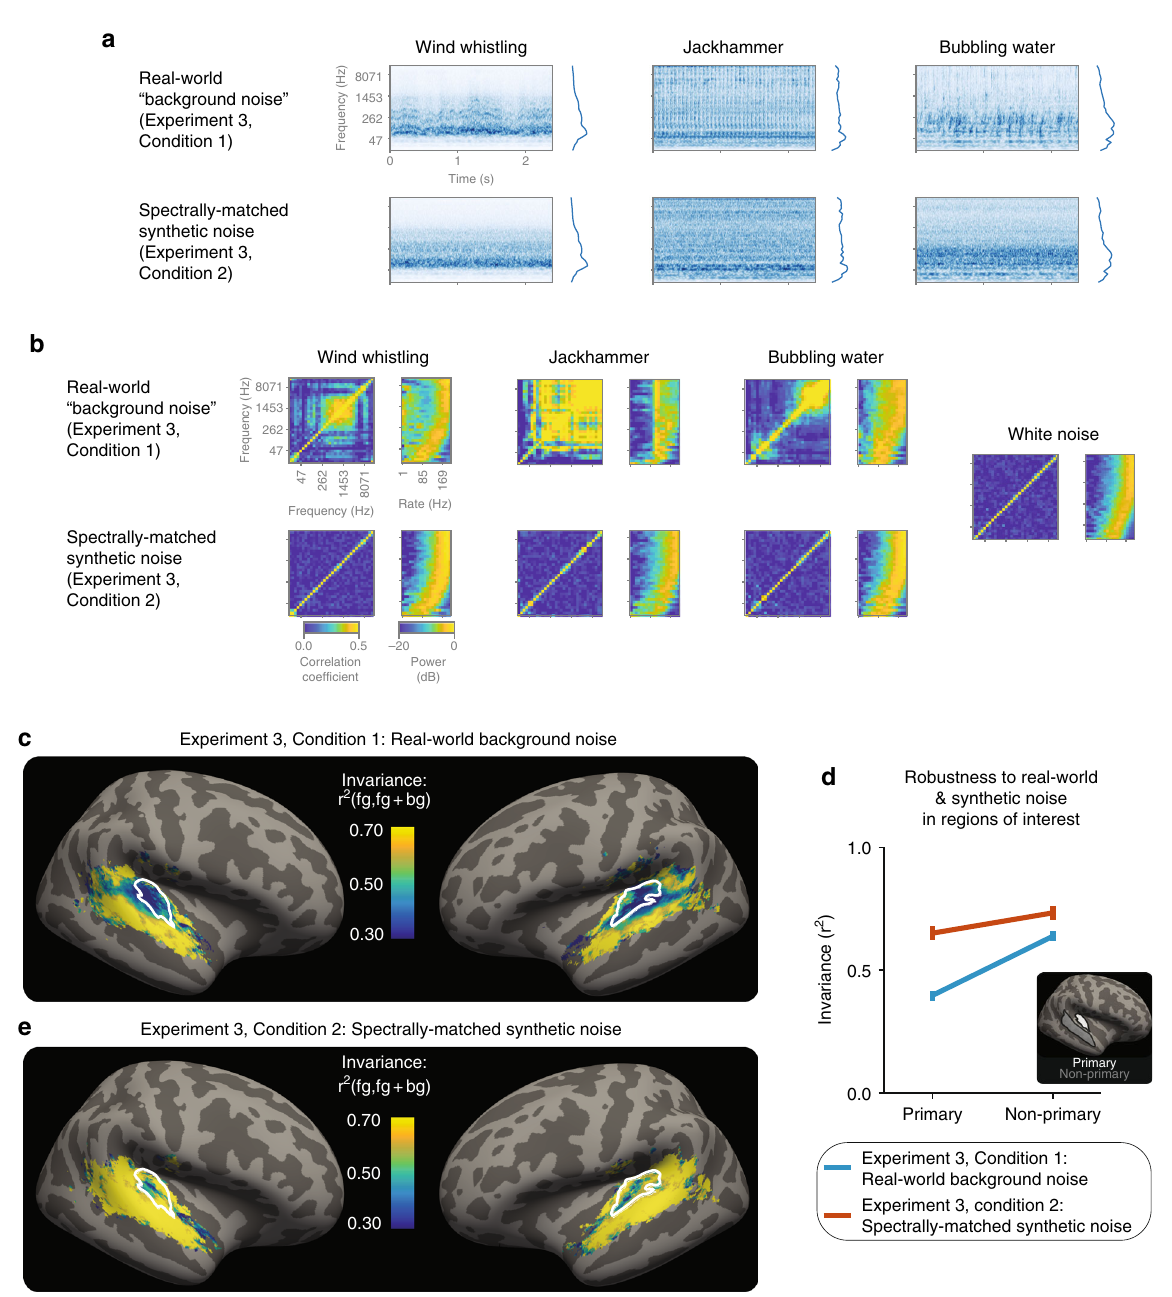
Fig. 3 Non-primary areas are particularly robust to real-world background noise. a Example cochleagrams of real-world background noises and spectrally matched synthetic noises. Average spectrum of each sound is shown to the right of each cochleagram. b Statistics of example real-world noises (top row) and spectrally matched synthetic noises (bottom row). Left subpanel show cross-channel envelope correlations; right subpanel shows modulation spectra, measured as power in a bank of modulation fi lters applied to each cochlear envelope. c The results of Experiment 3, Condition 1 ( n = 23): map of invariance metric for real-world background noises, averaged across participants. White outlines: primary-like areas, de fi ned anatomically. d Median of invariance metric in a primary and non-primary region of interest (ROI), averaged across participants and hemispheres. Error bars are within-participants SEM. Inset: outlines of anatomical ROIs. e The results of Experiment 3, Condition 2 ( n = 23): map of invariance metric for spectrally matched synthetic noises, averaged across participants. Plotting conventions, including colorscale, are identical to ( c grid, six of the sixteen squares were colored; the location of two of during each task condition were identical, as the stream of grids the six colored squares changed from stimulus to stimulus unless was displayed both during both tasks. The only difference the pattern repeated. Participants had to detect exact repeats, and between the two conditions was which task the participants were report these repeats with a button press within the ~700 ms performing. display period. Participants performed both tasks well (d-prime on visual task: mean of 3.3, range of 1.8 – 4.5; accuracy on auditory response magnitudes in auditory and visual cortex. Mean task: mean of 0.92, range of 0.83 – 0.99). The stimuli presented responses in the auditory cortex were higher during the auditory